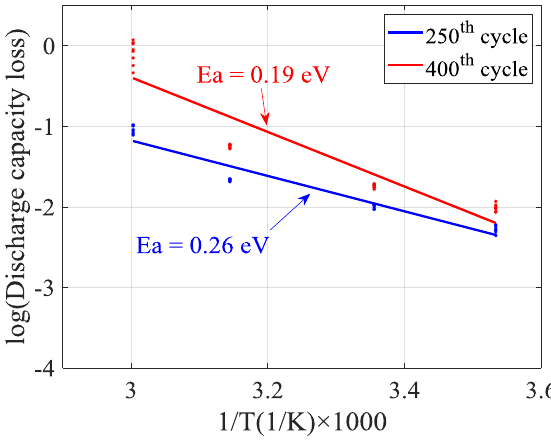
Figure 4. Logarithm of Q loss versus reciprocal of temperature.